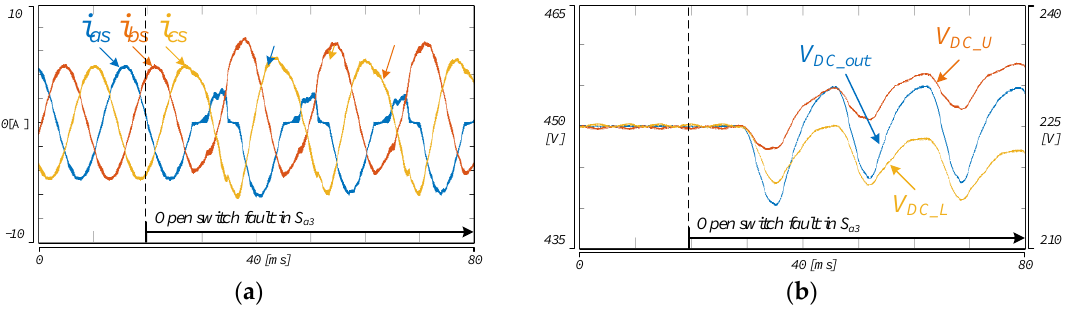
Figure 4. Three-phase currents and DC-link capacitor voltages under S x3 open-switch fault condition: ( a ) three-phase input current ( S a 3 ); ( b ) DC-link capacitor voltage ( S a 3 ).